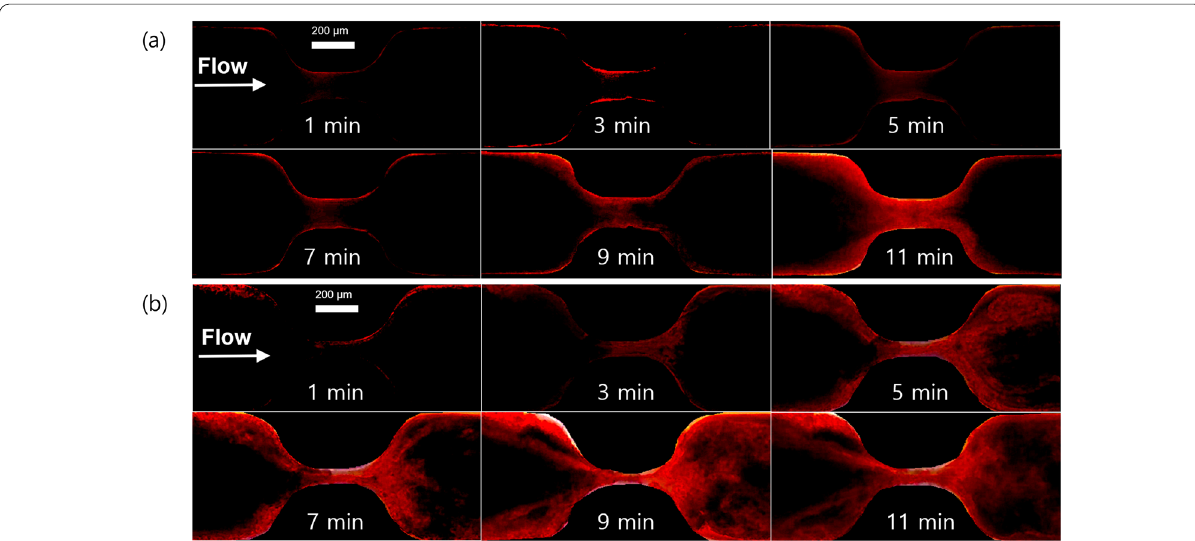
Fig. 5 Observation of the thrombus growth process through image analysis. The Thrombus begins to form on the wall of the channel and the thrombus grows around that area. ( a ) Thrombus growth process in the channel with 71.2% stenosis. ( b ) Thrombus growth process in the channel with 83.73%